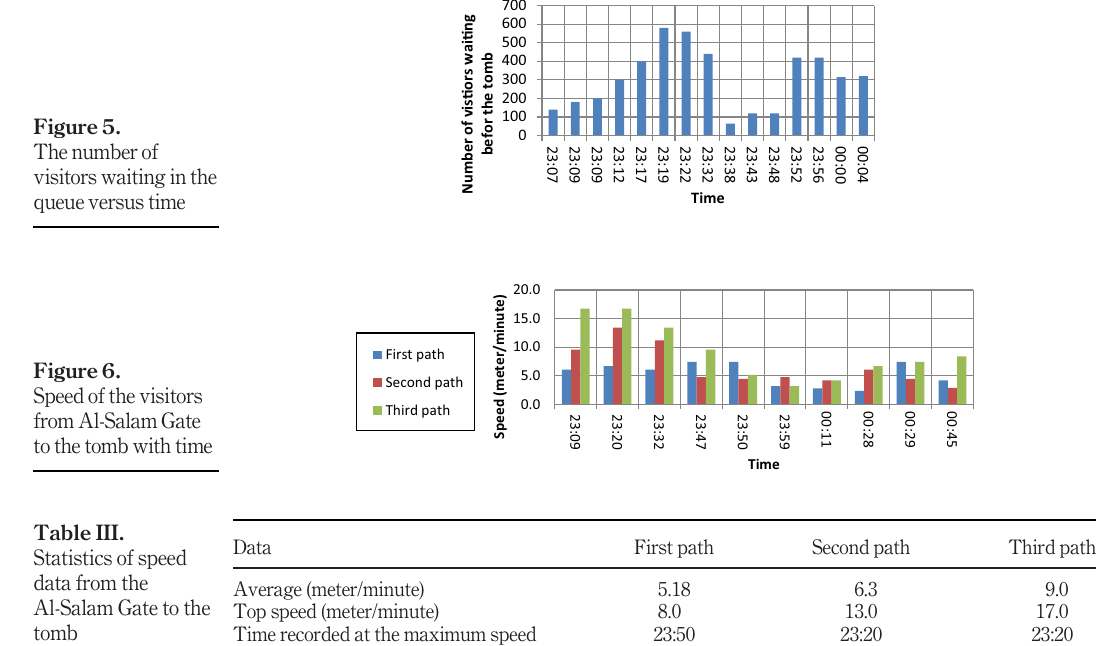
Figure 5. The number of visitors waiting in the queue versus